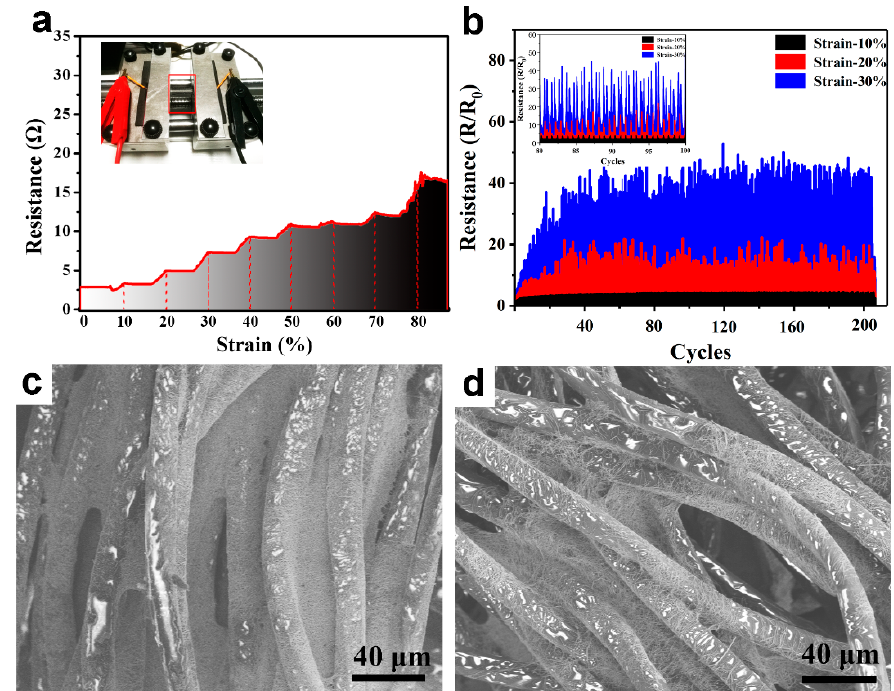
Figure 5. The resistance changes of the textile electrode with tensile strain (0–80%) and the insert image is the photograph of tensile test ( a ); the cyclic strain test if the textile electrode and the resistance change is cyclically stretched 200 times under the tensile strain of 10%, 20% and 30% ( b , the insert is the magnification of the data); SEM images of the surface of the textile electrode before stretching ( c ) and after 80% tensile strain ( d ).